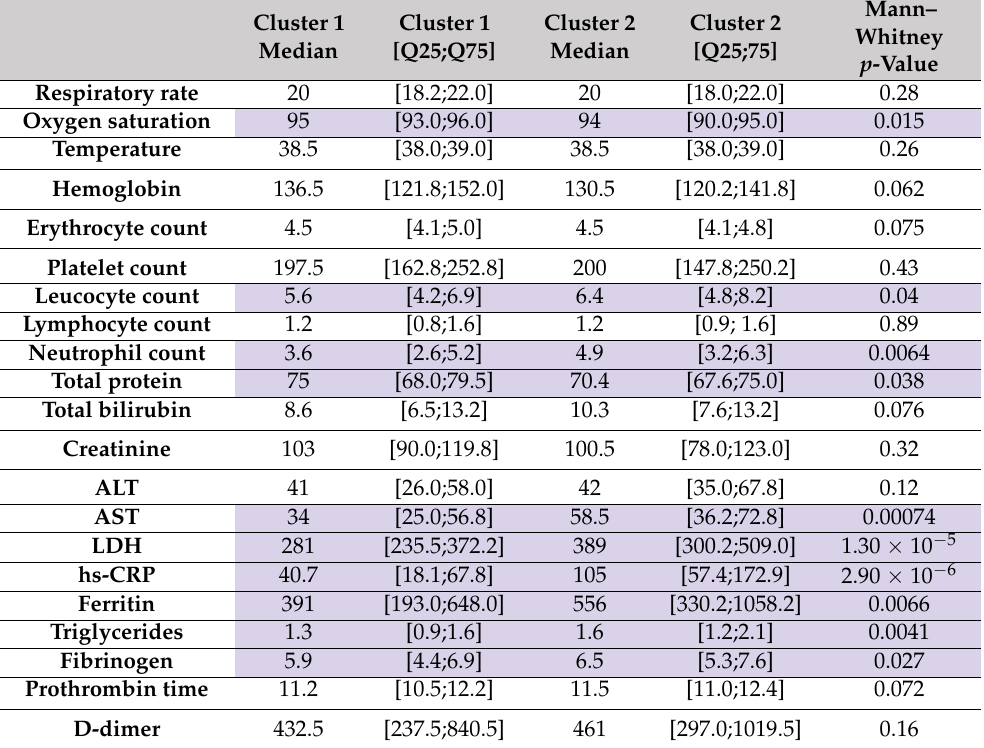
Table 2. Comparison of laboratory parameters between patients’ cytokine clusters. Data are pre- sented as median and interquartile range [Q25;Q75]. p -values are presented according to the Mann– Whitney test.